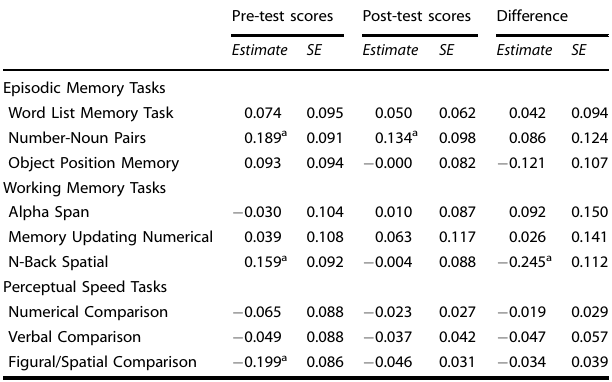
Table 1. Linear regression analysis between EAPGS and test scores by cognitive